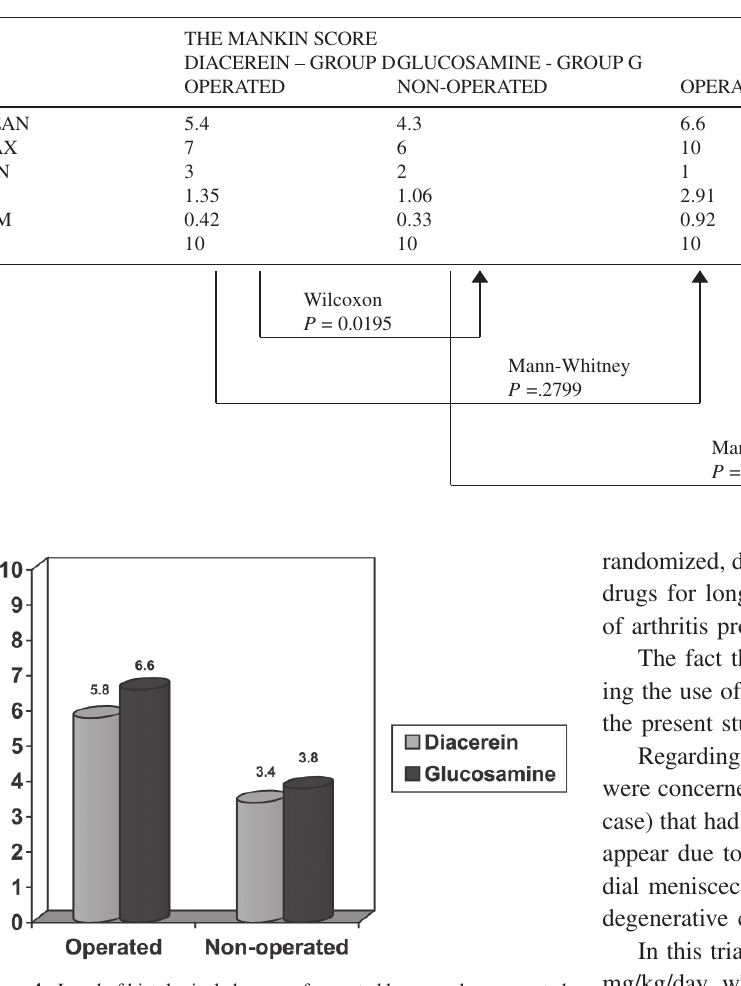
Figure 4 - Level of histological changes of operated knees and nonoperated knees receiving diacerein and glucosamine (Mankin score)